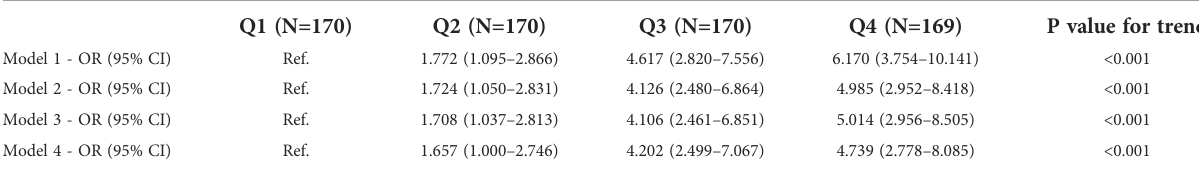
TABLE 2 Relations of Chinese visceral adiposity index with metabolic-associated fatty liver disease in patients with type 2 diabetes mellitus. CVAI